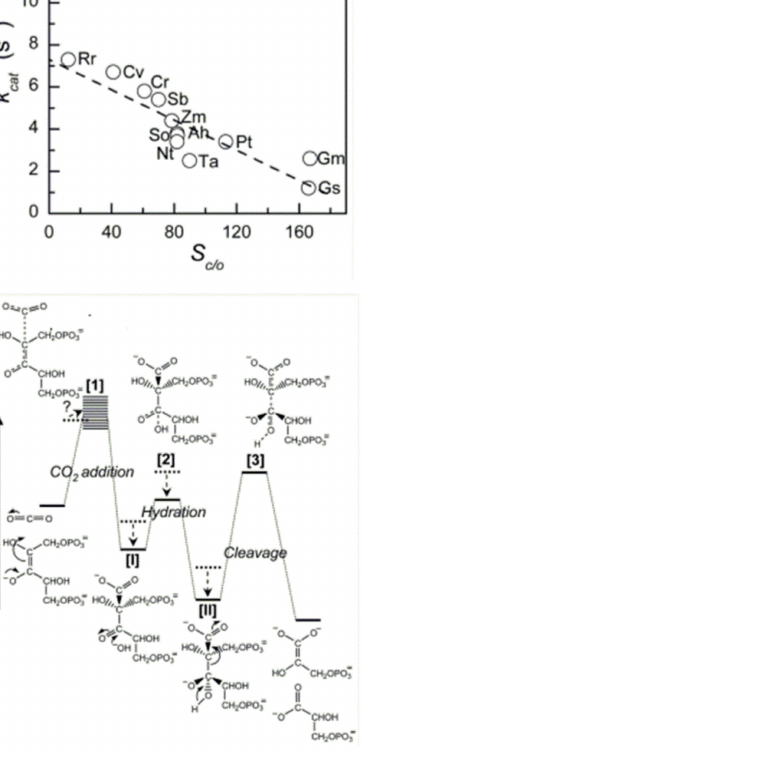
Figure 16. ( a ) k cat,C vs. S C/O dependence for various Rubiscos measured in vitro at 25 ◦ C. The organisms from which the Rubiscos were isolated were: Ag, Atriplex glabriuscula (C3 dicot); Ah, Amaranthus hybridus (C4 dicot); Av, Anabaena variabilis (cyanobacterium); Cr, Chlamydomonas reinhardtii (green alga); Cv, Chromatium vinosum (bacterium); Eg, Euglena gracilis (green alga); Gm, Griffithsia monilis (red alga); Gs, Galdieria sulfuraria (red alga); Nt, Nicotiana tabacum (C3 dicot); Os, Oryza sativa (C3 monocot); Pt, Phaeodactylum tricornutum (diatom); Rr, Rhodospirillum rubrum (bacterium); Rs, the bacterial symbiont of the tubeworm Riftia pachyptila ; Sb, Sorghum bicolor (C4 monocot); So, Spinacia oleracea (C3 dicot); S6301, Synechococcus PCC 6301 (cyanobacterium); S7002, Synechococcus PCC 7002 (cyanobacterium); Ta, Triticum aestivum (C3 monocot); and Zm, Zea mays (C4 monocot). Dotted line is a linear regression through all the data except for cyanobacteria (S6301 and S7002) which were excluded. ( b ) Energy profile along the Rubisco-catalyzed carboxylation reaction evidencing the structure of Transition States and Intermediates (Figure 16 from ref. [50], adapted and used by permission of PNAS (copyright ©